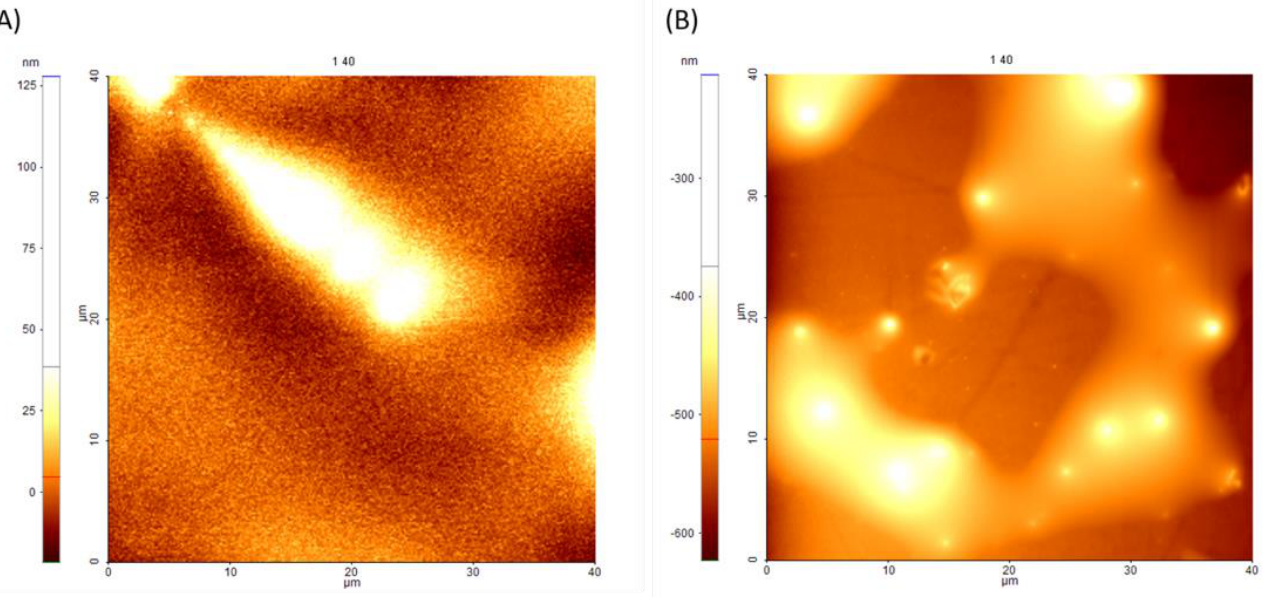
Figure 2. Atomic force microscopy images of pMPC dropcasted onto ( A ) Si with smooth, homogenous and random linear microfeatures surfaces; and ( B ) onto Si PDMS surface, characterised by the accumulation of pMPC microislands onto the surface. Scan area: 40 × 40 µm 2.